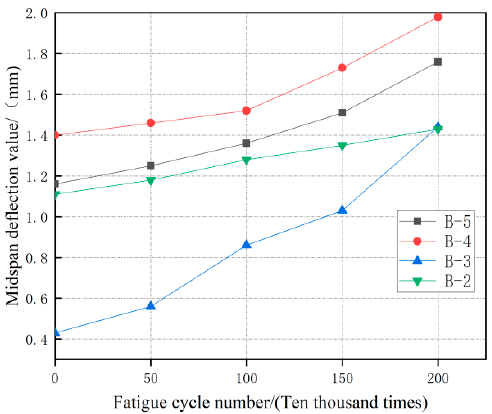
Figure 12. Deflection rend diagram of fatigue process by freeze–thawing erosion of strengthened test plate.